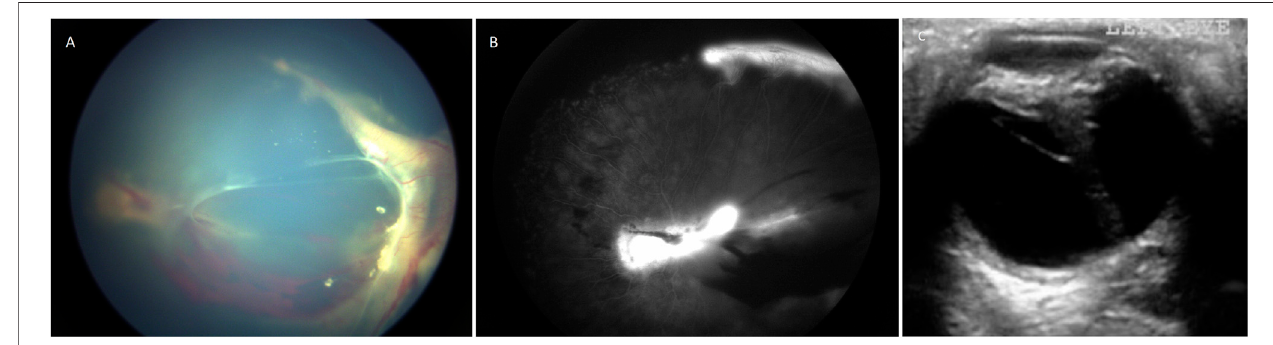
FIGURE 1 | (A) Colour fundus photograph showing an example of moderate retinopathy. (B) Fluoresceine angiogram of the same eye. (C) An ultrasound B scan showing an example of severe retinopathy. This child with Norrie disease has a total retinal detachment in a closed funnel con fi